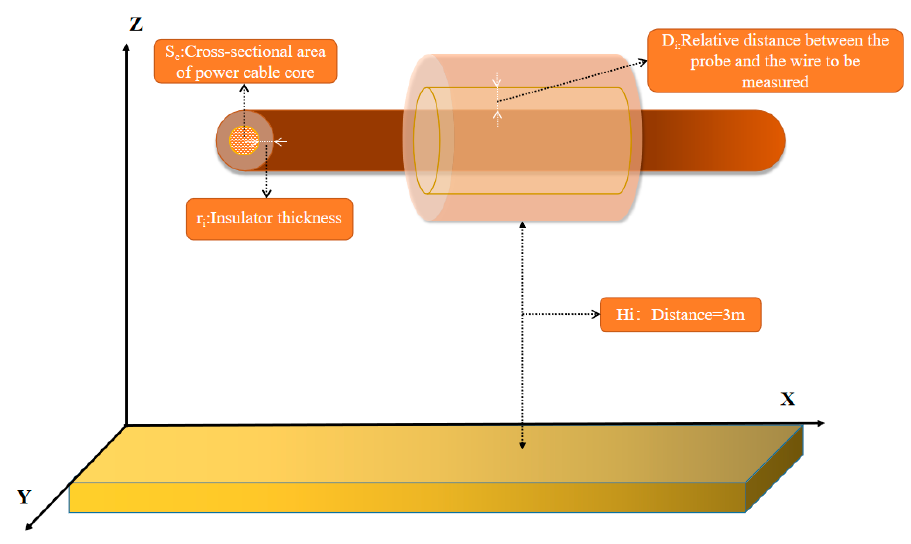
Figure 2. Simulation model schematic.